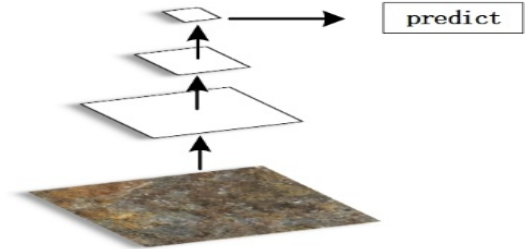
Figure 8. Single feature extraction.